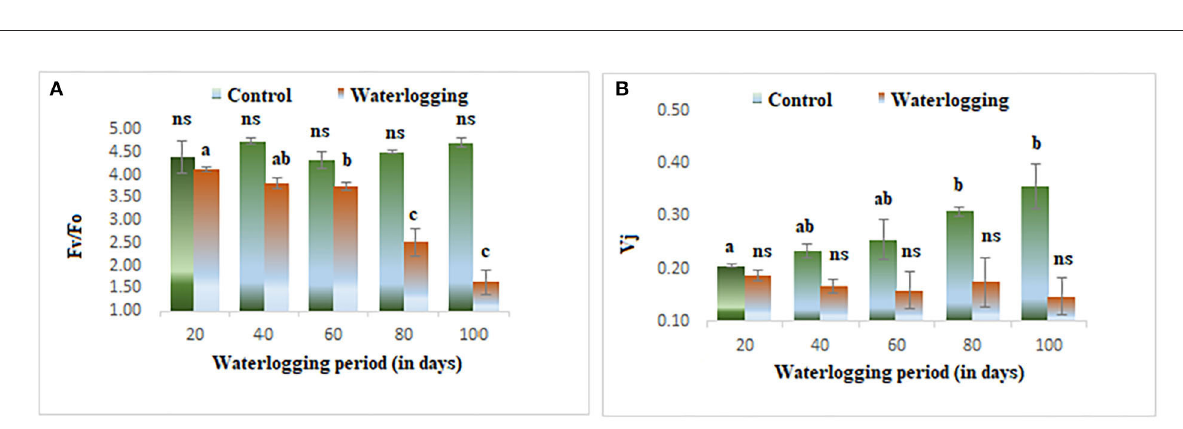
FIGURE4 Waterlogging-induced changes in (A) Fv/Fo (B) Vj. The letters are the result of post hoc